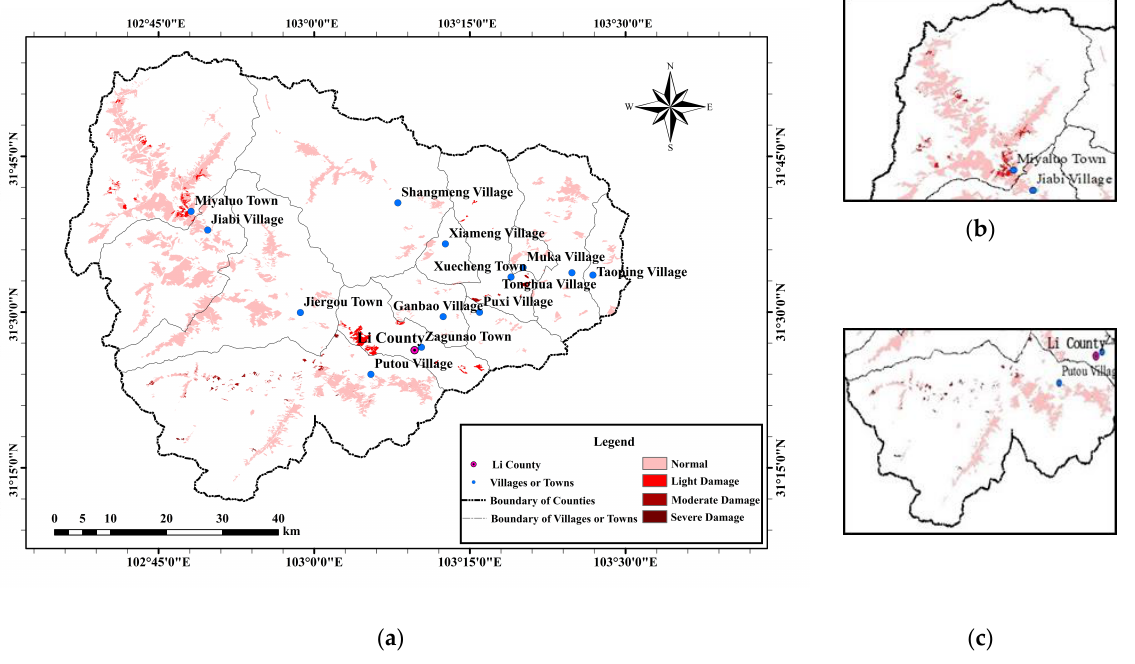
Figure 6. The remote sensing investigation results of Lophodermium piceae for Li County: ( a ) the global investigation results of Lophodermium piceae for Li County; ( b ) the investigation results for Miyaluo Town; ( c ) the investigation results for Putou Village.